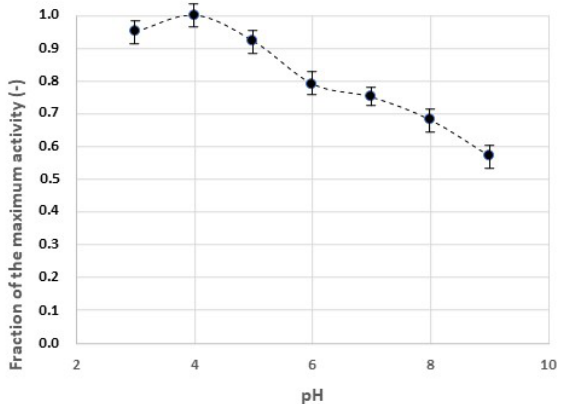
Figure 3. Effect of pH on the catalytic activity of the laccase. Substrate: 5 mM ABTS. T = 37 °C. Reaction time: 10 min.